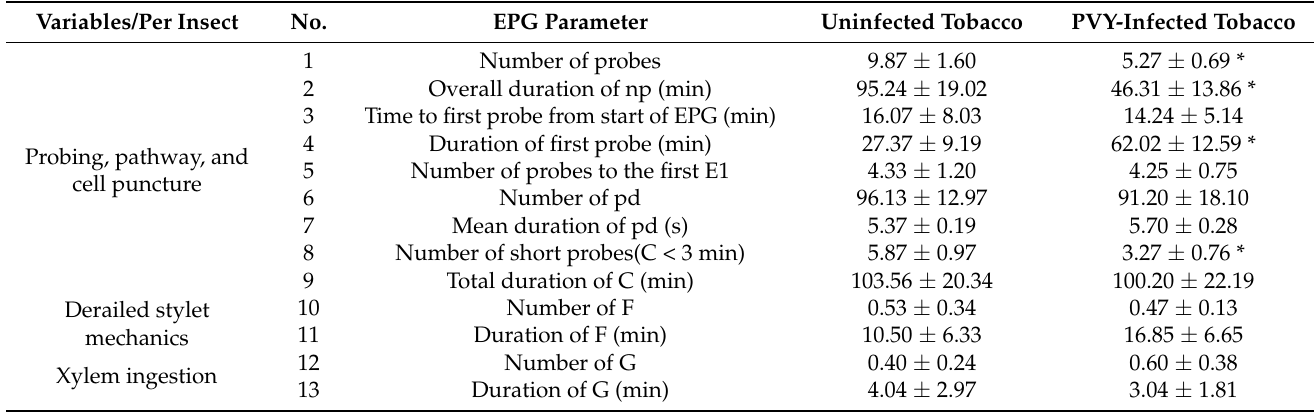
Table 1. EPG variables of M. persicae probing behavior on uninfected tobacco and PVY-infected tobacco during the 6 h recording